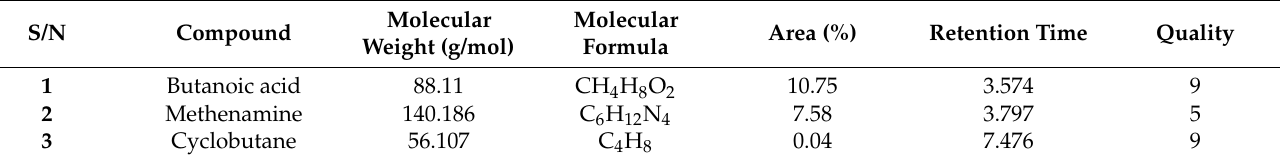
Table 2. Organic constituents of methanolic P. amarus leaf extract revealed by GC-MS. Molecular S/N Compound Weight (g/mol)